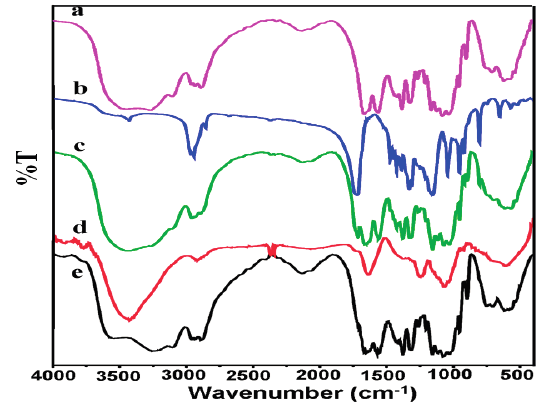
Figure 4. FTIR spectra of composite sponge ( a ) chitin, ( b ) PBS, ( c ) chitin/PBS, ( d ) chondroitin sulfate, and ( e )